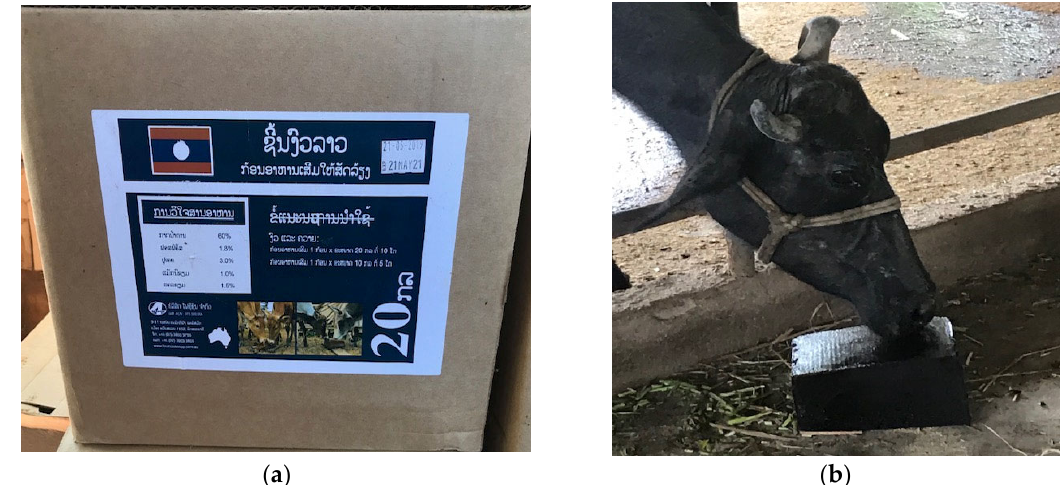
Figure 1. (a) MNB provided to farmers in Lao PDR; ( b ). buffalo cow consuming